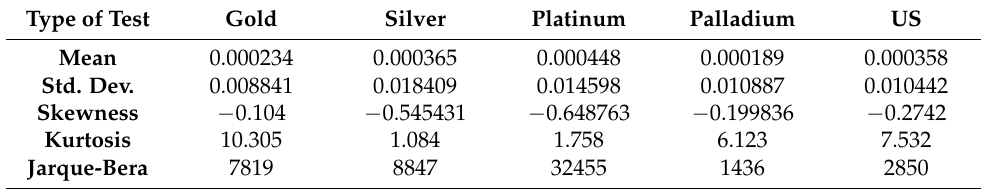
Table A1. Descriptive Statistics of the Precious Metals.